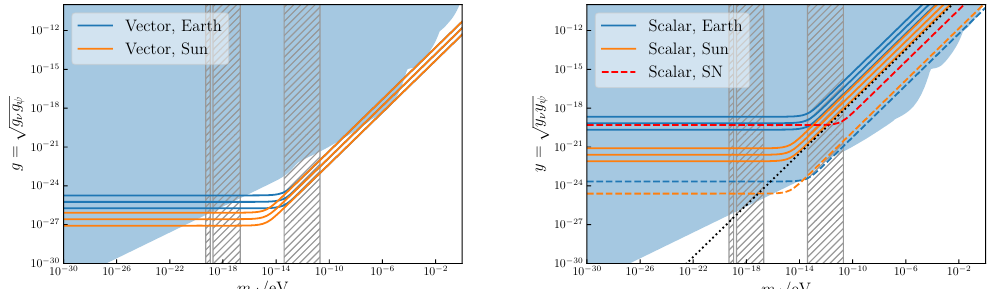
Figure 2 . The regions of masses and couplings of ultra-light vector (left) and scalar (right) mediators in which signi(cid:12)cant e(cid:11)ects are produced by the matter of the Earth at its surface (blue lines) and by matter of the Sun in its center (orange lines). The blue shaded regions are excluded by the combination of various observations (explained in the text). The grey hatched regions are excluded by black hole super-radiance. Left panel : lines of equal potentials generated by vector mediator. From down to up: V=V SM = 10 (cid:0) 2 ; 10 (cid:0) 1 ; 1 . Right panel : lines of equal corrections to f g the neutrino mass generated by scalar mediator. From down to up: (cid:14)m (cid:23) = eV = 10 (cid:0) 3 ; 10 (cid:0) 2 ; 10 (cid:0) 1 . f g For comparison, we plot two dashed lines with (cid:14)m (cid:23) = 10 (cid:0) 11 eV for the Earth and (cid:14)m (cid:23) = 10 (cid:0) 8 eV for the Sun which have parts below the excluded regions. Red dashed line corresponds to (cid:14)m (cid:23) = 5 MeV generated by the core of supernovae. The region above this line is excluded (see